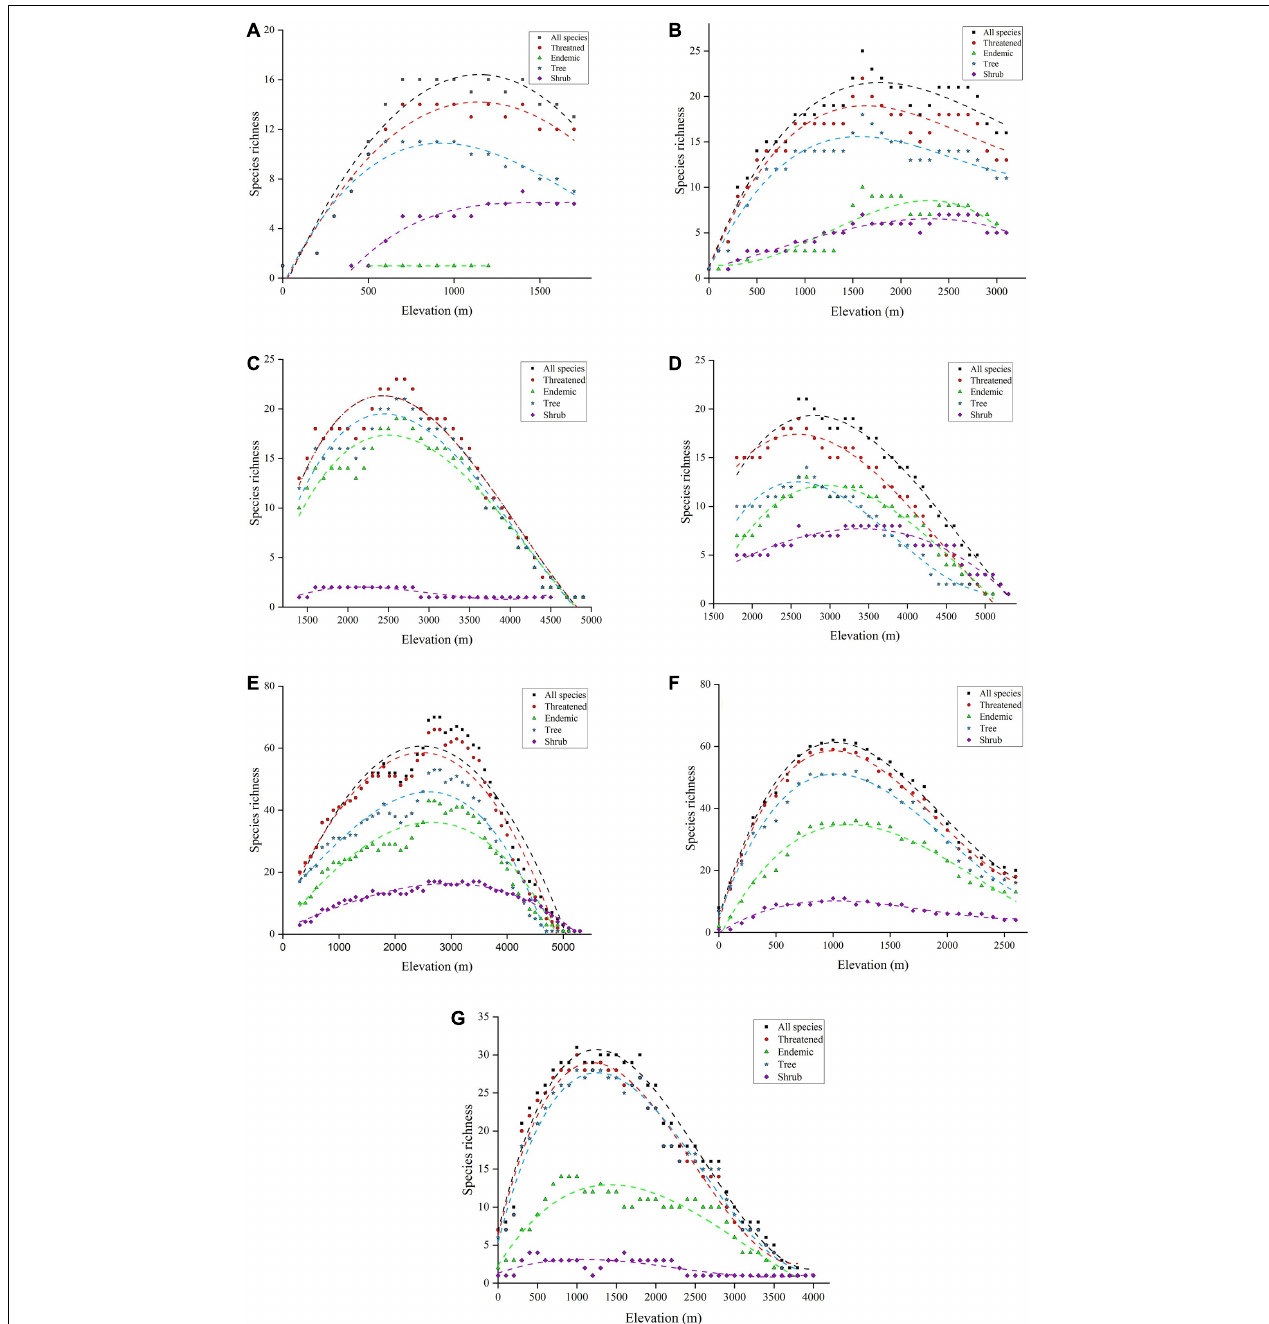
FIGURE 4 | Gymnosperm distribution patterns along elevation gradients in ecoregions of China— (A) Eco 12 (East–Manchurian region), (B) Eco 19 (Central China–Loess plateau), (C) Eco 20 (Qilian mountain region), (D) Eco 22 (Tibetan Plateau), (E) Eco 27 (Hengduan–Qionglai mountain region), (F) Eco 33 (South China region), and (G) Eco 34